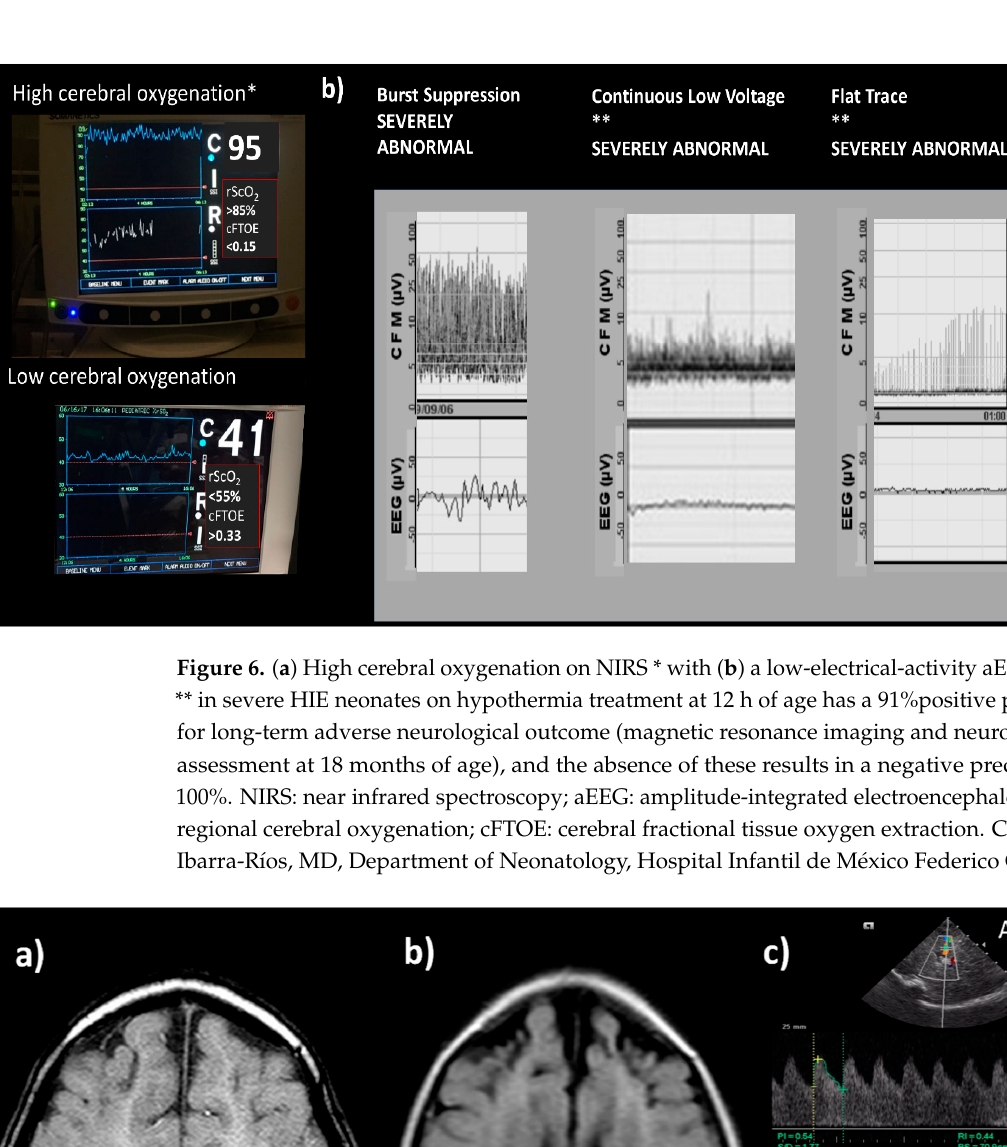
Figure 7. Magnetic resonance: ( a ) axial image of sequence enhanced in T1 towards convexity and ( b ) enhanced in FLAIR, where hyperintensity of the bilateral semioval centers is observed, as well as a decrease in volume in bordering territory in parietal regions and in the smaller frontal portion with retraction of the lateral ventricles associated with hyperintensity of the periventricular white matter. Courtesy: Eduardo M. Flores Armas, MD, Department of Medical Imaging. Cranial ultrasound: ( c ) low RI (<0.55) in normothermic infants or after rewarming has an 84% positive predictive value for death or disability. Courtesy: Daniel Ibarra-R í os, MD, Department of Neonatology, Hospital Infantil de M é xico Federico G ó mez. ACA: anterior cerebral artery; MCA: medial cerebral artery; RI: resistive